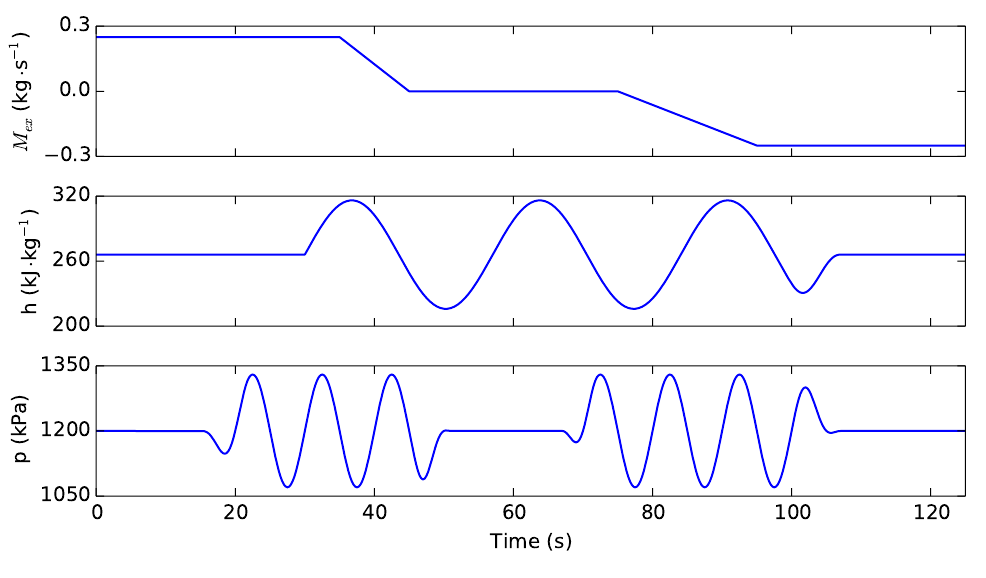
Figure 5. Boundary conditions of the flow reversal test.